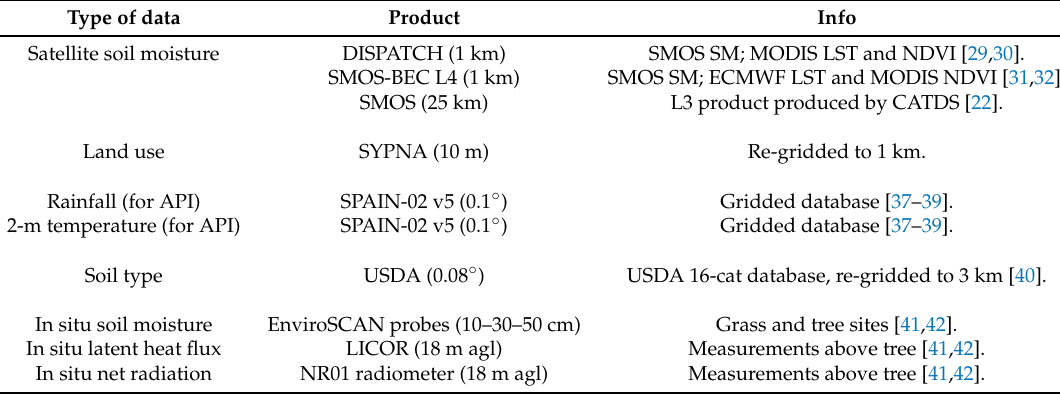
Table 1. Brief summary of the different types of data used in this work. The original resolution of the products and their more important re-processing is included in the info